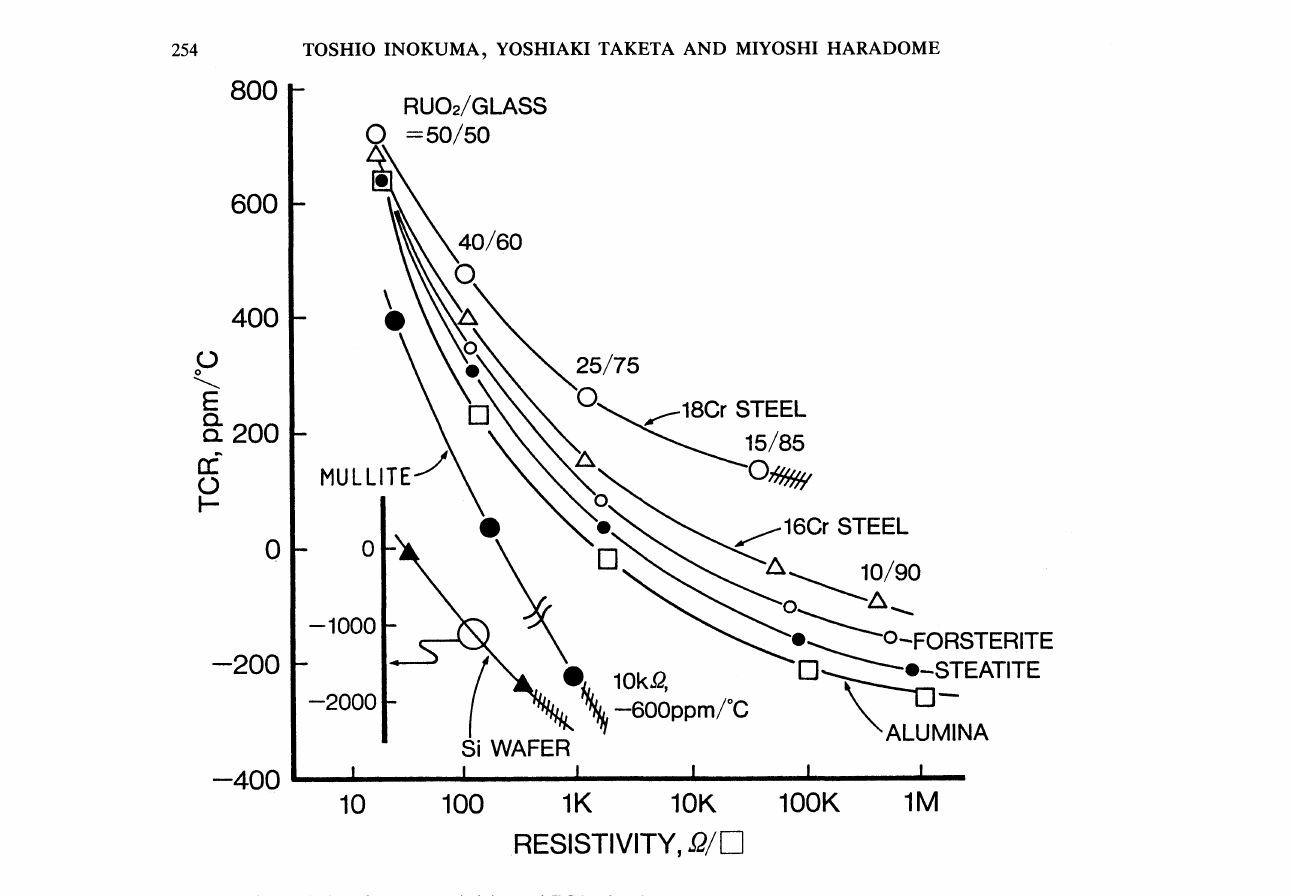
FIGURE 3 Relations between resistivity and TCR of resistors on various substrates. (RuO2/glass 50/50 to 10/90 firing temperature 800C) Figure 3. When the difference in coefficient of thermal expansion is larger between the resistor and substrate, the resistance values become unstable in the high resistance range. The resistors in the hatched areas in Figure 3 showed unstable